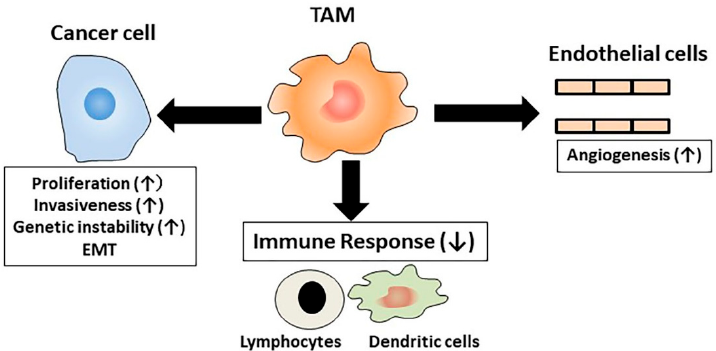
Figure 3. Effects of tumor-associated macrophage (TAM) on tumorigenesis. TAMs affect cancer cells by enhancing proliferation and invasiveness and inducing genetic instability and epithelial-mesenchymal transition (EMT). TAMs enhance angiogenesis and suppress tumor immunity.